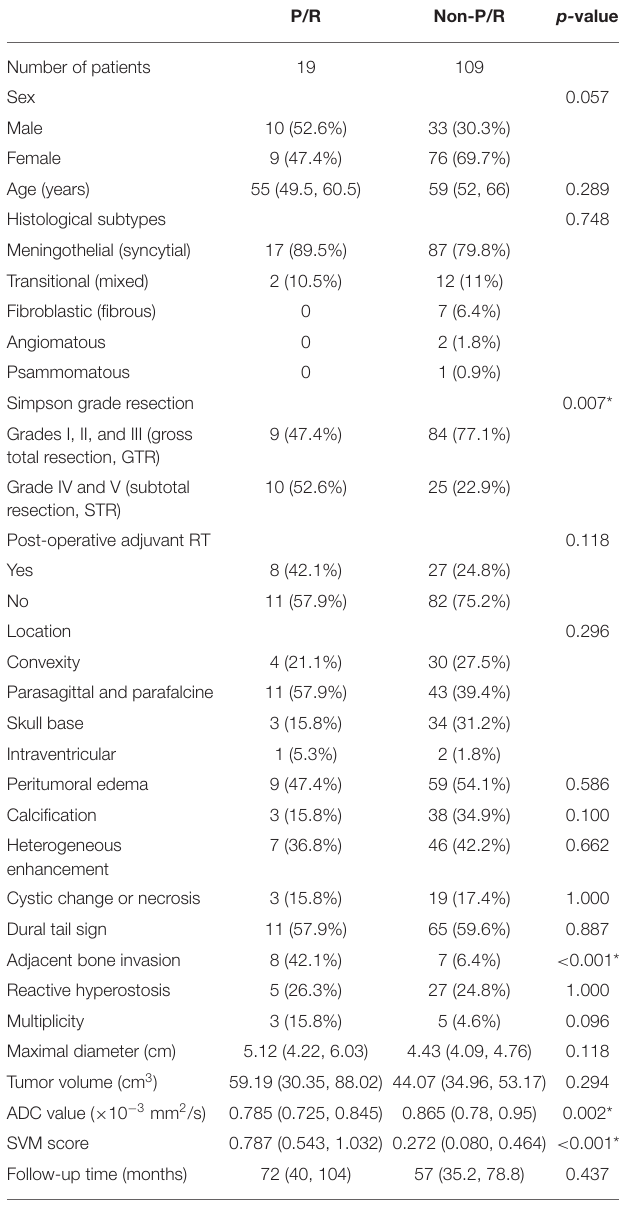
TABLE 1 | Clinical data and conventional MRI findings of meningiomas with and without progression/recurrence